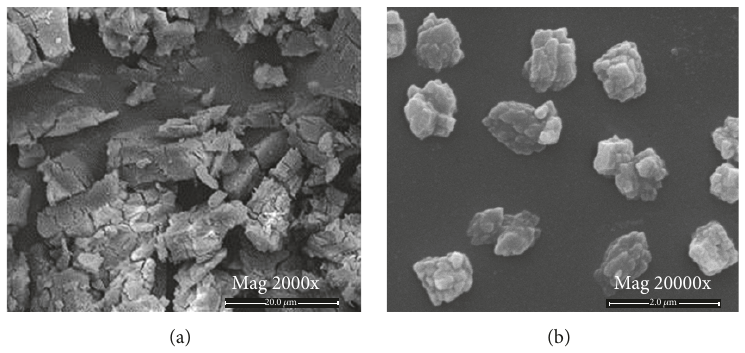
Figure 1: SEM images of (a) raw HCPT and (b) HCPT primary particles.